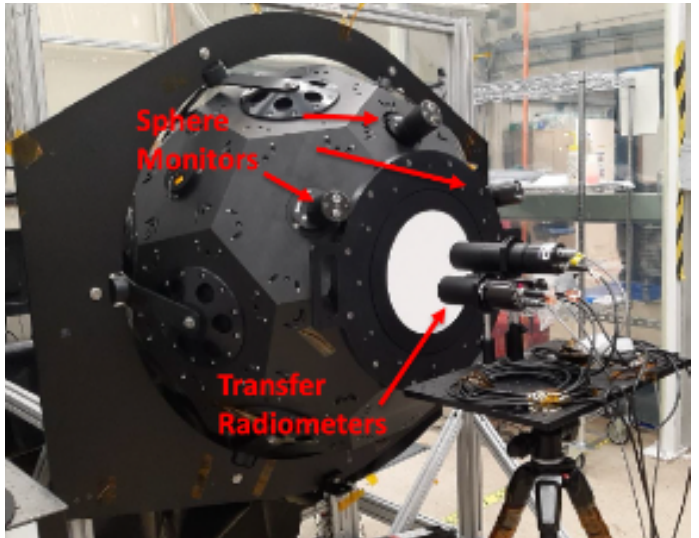
Figure 4. The lab setup for the Sphere Calibration to transfer the NIST calibration to the GLAMR sphere monitors. (Picture courtesy of the GLAMR